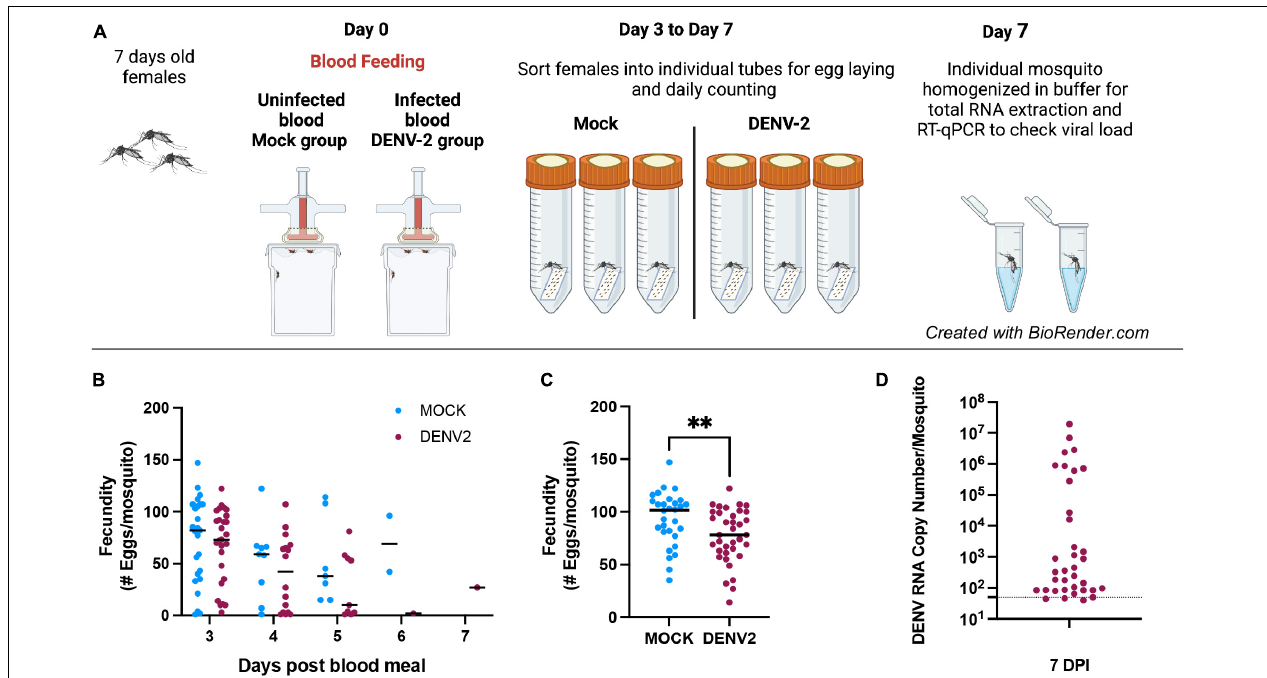
FIGURE 1 | Mosquito egg production can be affected by DENV-2 infection during the first gonadotropic cycle. (A) Schematic of the DENV-2 infection process as further detailed in the “Materials and Methods” section. (B) Mosquito fecundity after infectious blood meal (DENV2) compared to uninfected blood meal (mock) per time point 3–7 days. (C) Overall fecundity of infected mosquitoes. Representative results from two independent experiments analyzed per group ∗∗ p < 0.005 (Mann-Whitney test). (D) Viral load from mosquito bodies at 7 DPI by RT-qPCR using 10-fold dilution of DENV-2 standard RNA, ranging from 10 8 to 10 1 copies/ µ l. Mosquitoes’ body were tested for DENV-2 infection and only positive females were considered for fecundity graphs. Mock n = 30, DENV-2, n = 36.